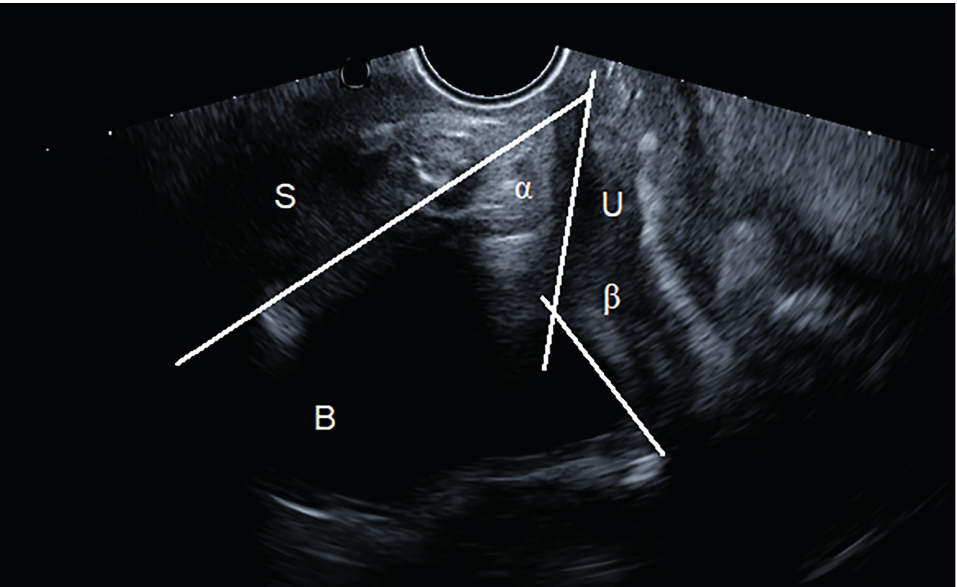
Figure 1 - α and β angles at rest (presented as image in the form of TIFF